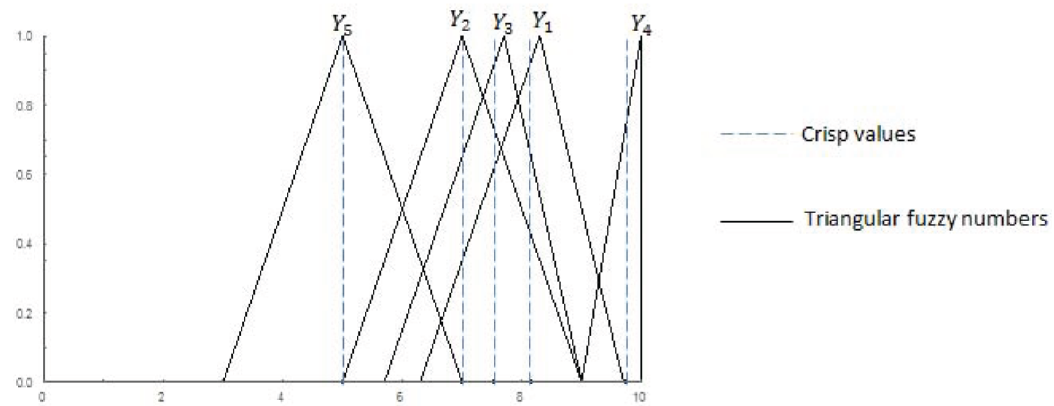
Figure 4. Triangular fuzzy numbers and their crisp values of each criterion for alternative A 2 .